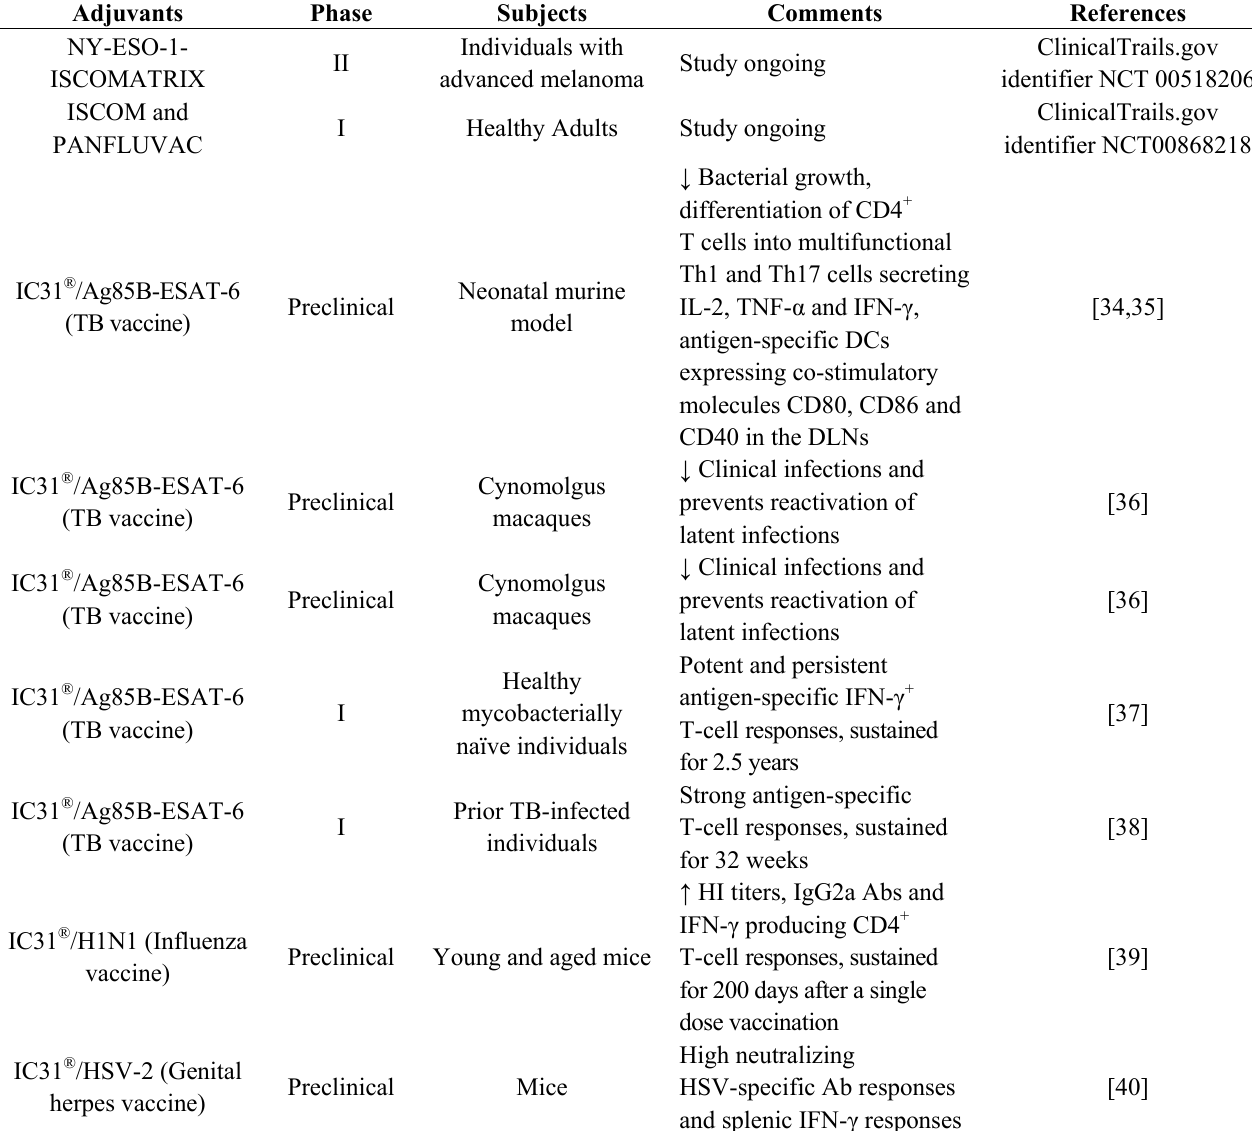
Table 2. ISCOMs and IC31 ® : Preclinical and clinical